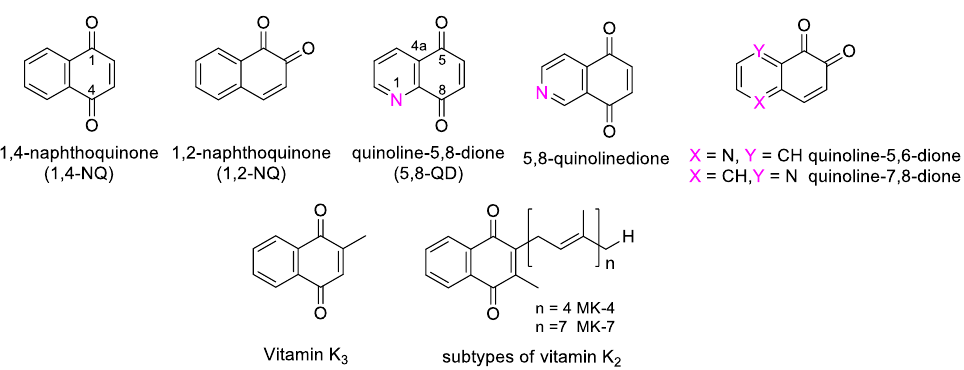
Figure 1. Molecular structures of naphthoquinones and the most common quinolinediones, and of vitamin K2 and K3.